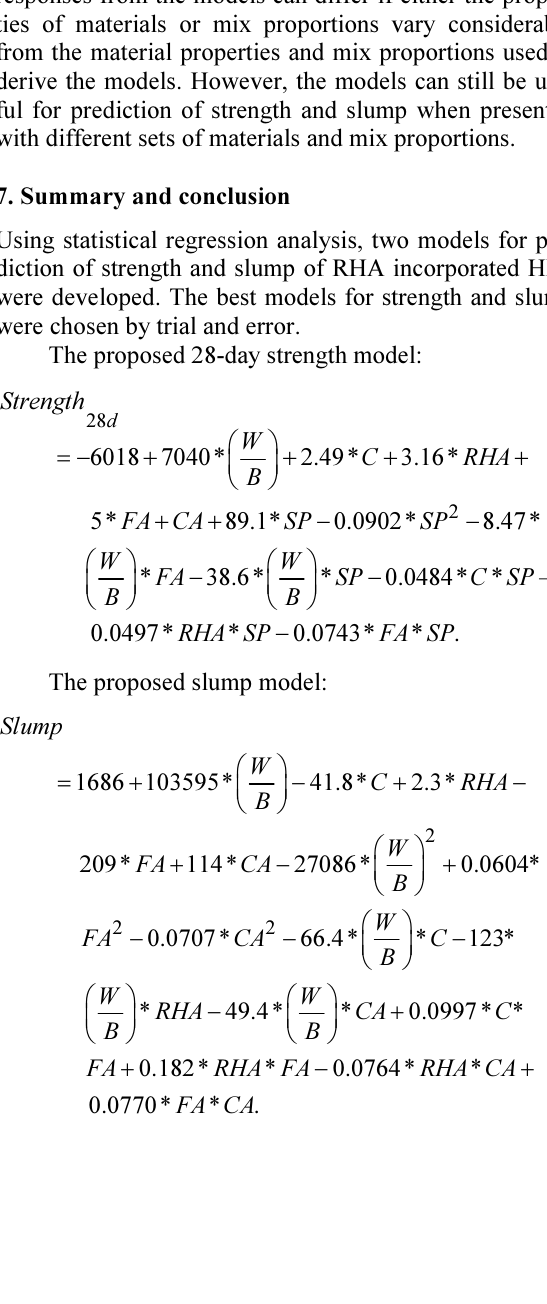
Table 8. Comparison of experimental and predicted values of strength and slump for the data of Table 7 Strength (MPa) Slump (mm) Variation (%) Mix No. Experiment Prediction Experiment Prediction Slump